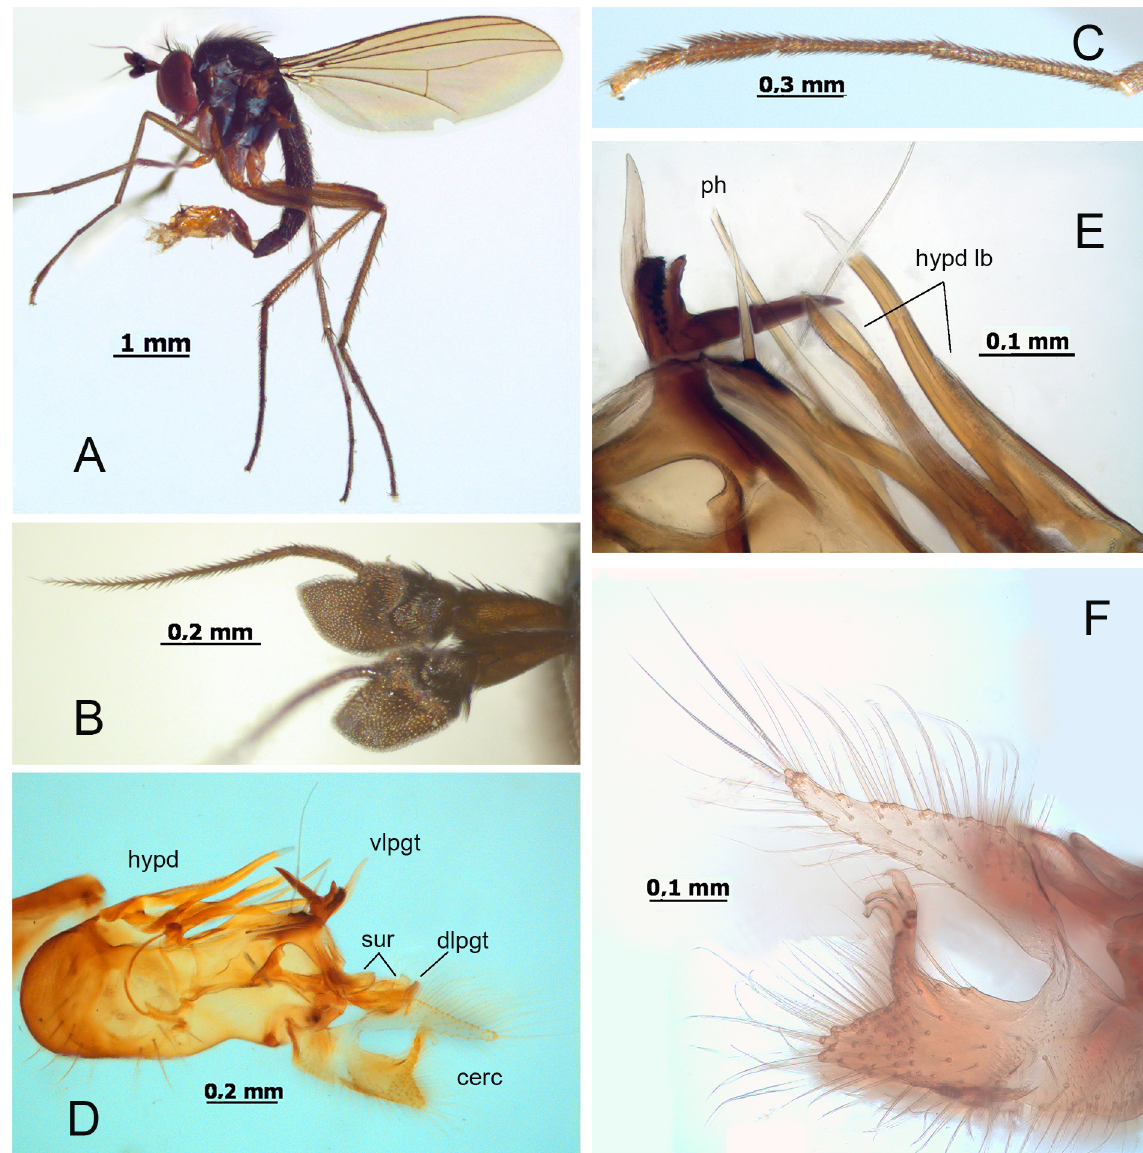
Fig. 4. Hercostomus koshelevae sp. nov., ♂, holotype (MNSA; A–C); ♂, paratype, Town Bush (MNSA; D–F). A . Habitus. B . Antenna. C . Fore tarsus. D . Hypopygium, right lateral view. E . Distoventral appendages of epandrium. F .